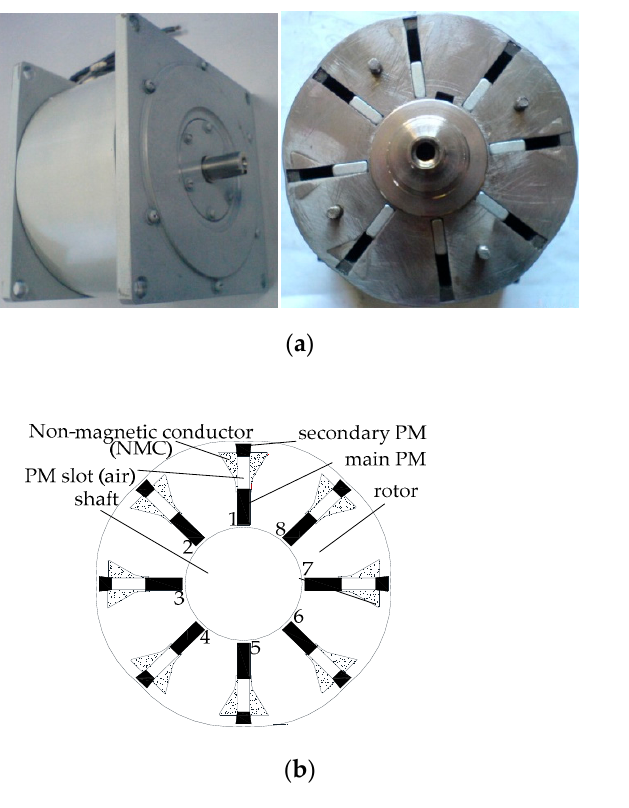
Figure 1. The new permanent magnet synchronous motor (PMSM): ( a ) the prototype of the motor; ( b ) the cross section of the rotor.